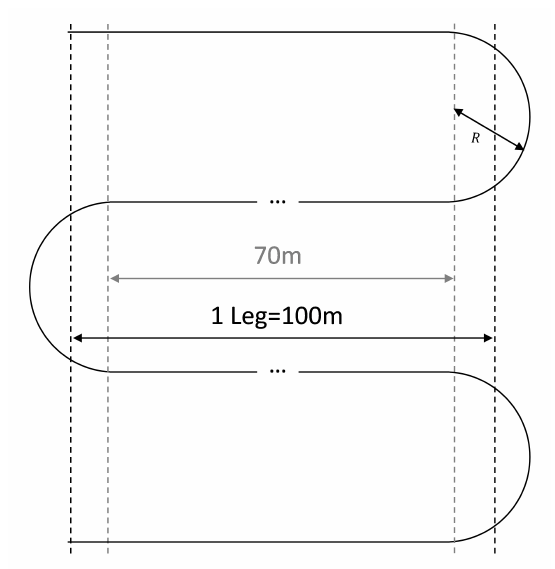
Figure 8: Top view of the flight path during the 120 s with the depic- tion of the legs trajectories.